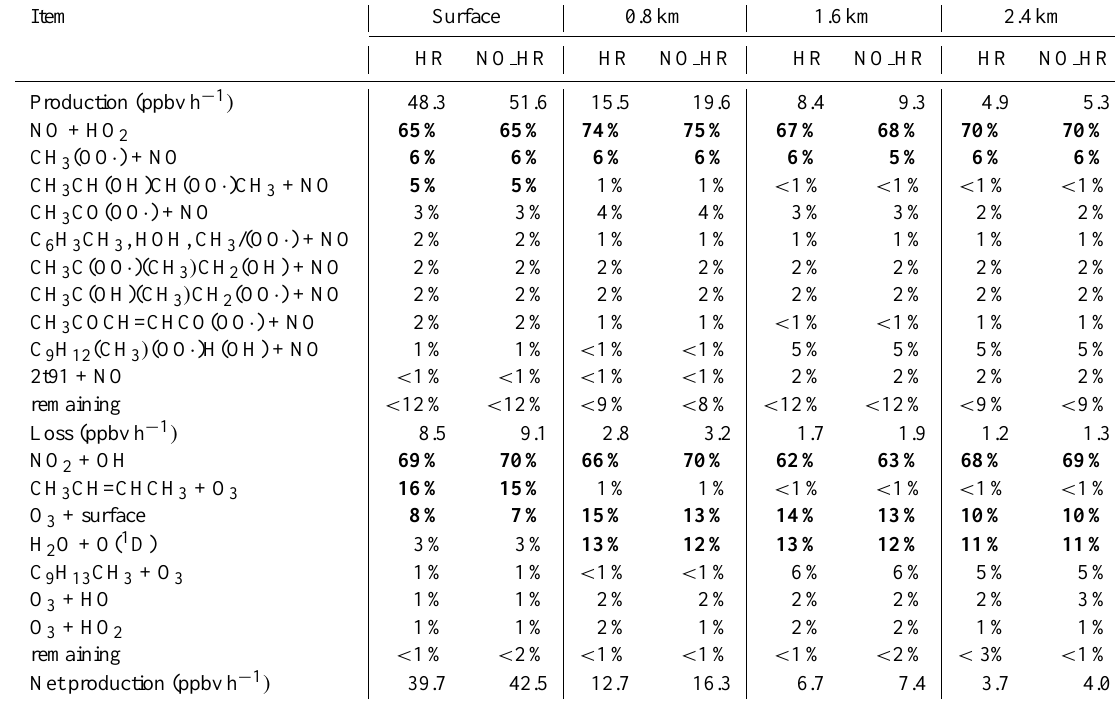
Table 6. Ozone budget at different altitudes based on a model analysis of measurement data with and without considering heterogeneous reactions (HR) of OH and HO 2 on aerosol